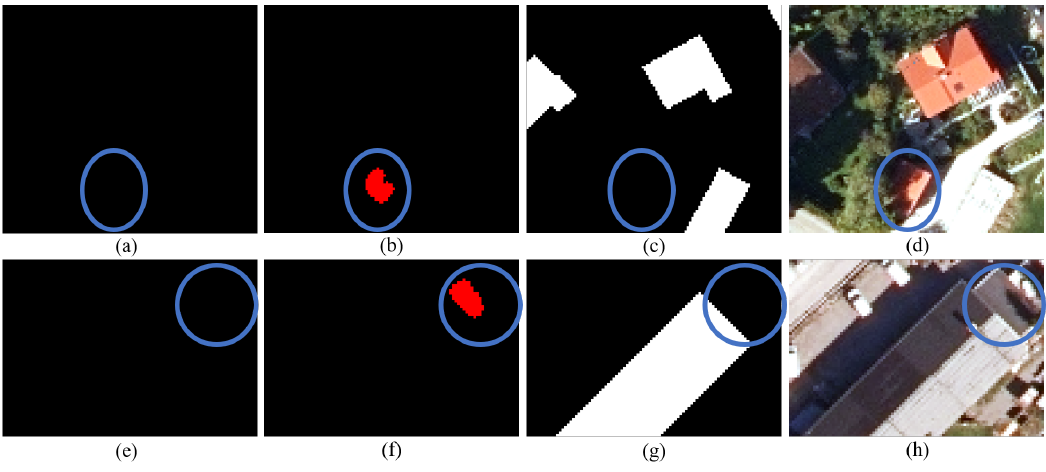
Figure 9. The new undocumented buildings in Bad Toelz obtained from (a), (e) Trained model 1, (b), (f) Trained model 2, and their corresponding (c), (g) DFK as well as (d), (h)